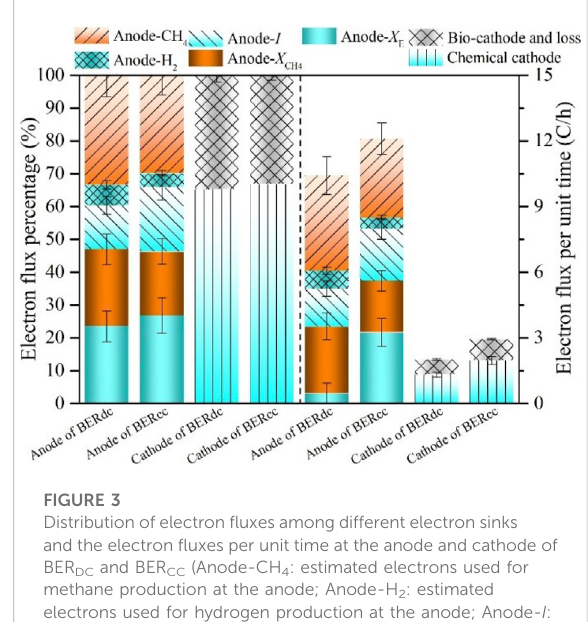
FIGURE 3 Distribution of electron fl uxes among different electron sinks and the electron fl uxes per unit time at the anode and cathode of BER DC and BER CC (Anode-CH 4 : estimated electrons used for methane production at the anode; Anode-H 2 : estimated electrons used for hydrogen production at the anode; Anode- I : electrons transferred from the anode to the cathode to generate currentattheanode;Anode- X CH4 :estimatedelectronsconsumed for methanogen growth at the anode; Anode- X E : estimated electrons consumed for exoelectrogen growth at the anode; Bio- cathode and loss: estimated electrons transferred to the bio- cathodeorlossintransfer;Chemicalcathode:estimatedelectrons transferred to the chemical